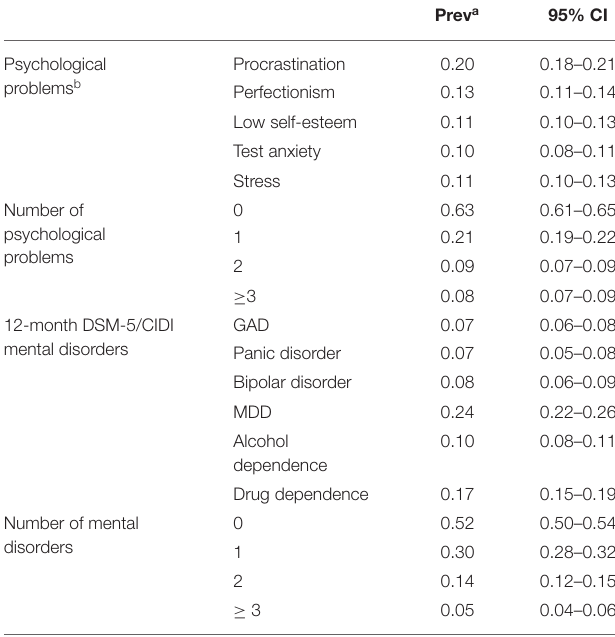
TABLE 1 | Distributions of common psychological problems and mental disorders among university